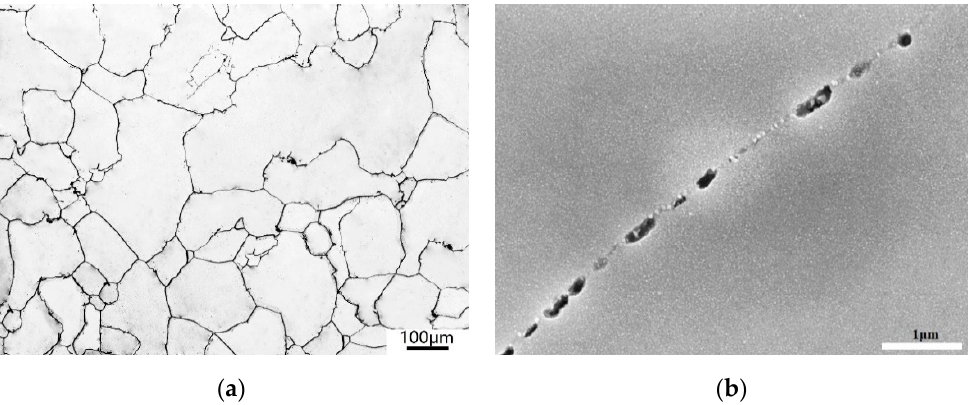
Figure 1. Initial microstructure of HY282 alloy prior to hot compression: ( a ) optical microstructure, ( b ) scanning electron microscope (SEM) microstructure.